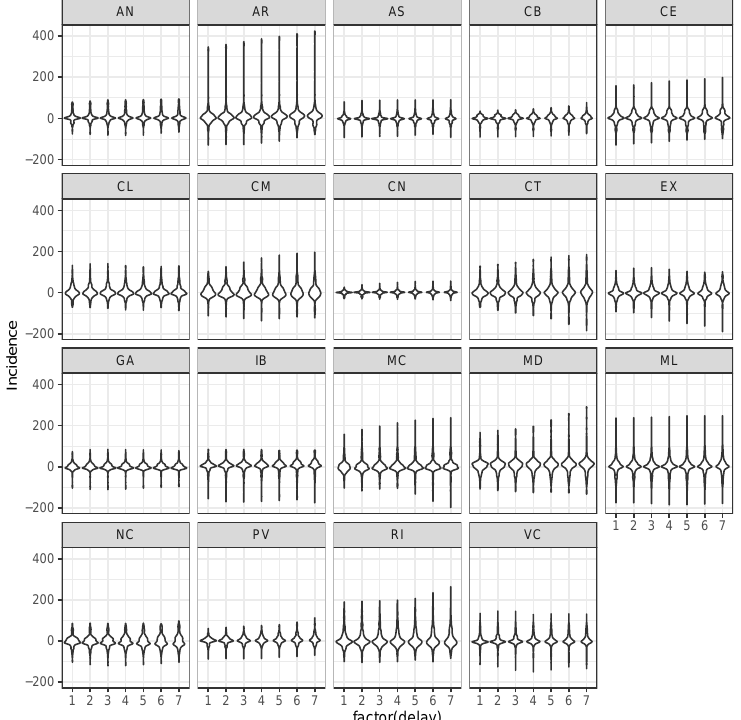
Figure 2. Violin plots of distributions of differences (cid:98) y ts − y ts conditionally to the region and the number of days ahead in the prediction, namely the delay d . The variance of the LSTM used for the Poisson mean elicitation is just the average of the squared differences (cid:98) y ts − y ts . These increase as there is more uncertainty in predicting with delay d = 7 than d =